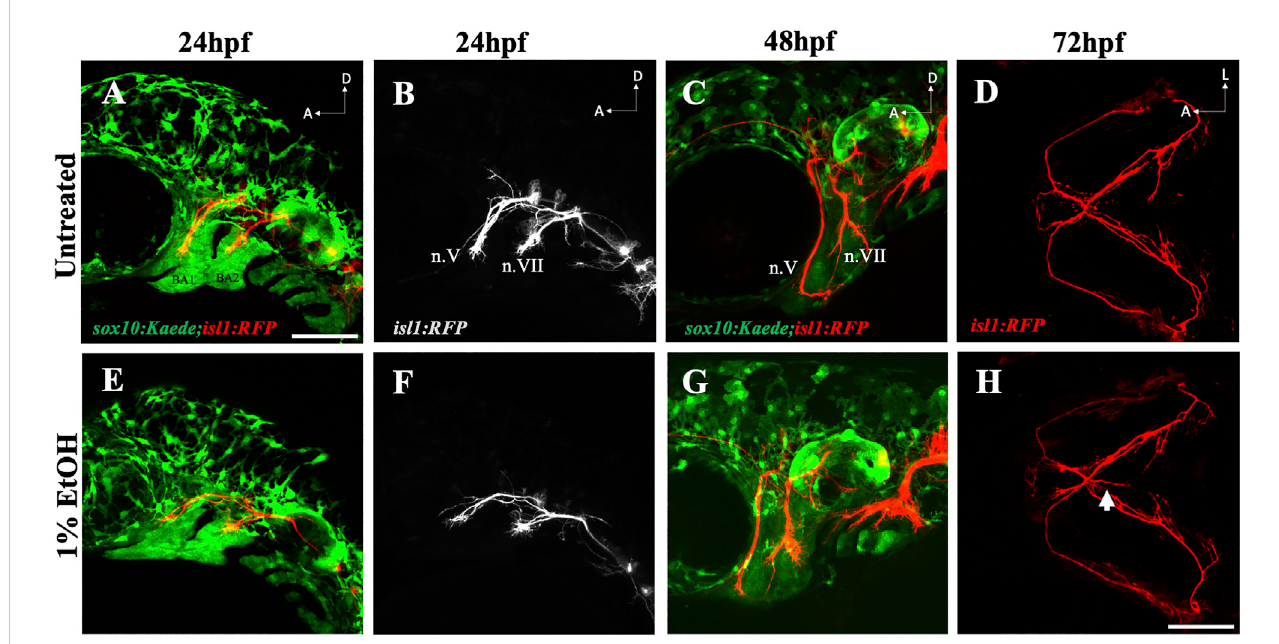
FIGURE 8 Ethanol does not affect early cranial nerve routing and path fi nding (A, B) Trigeminal nerve (n.V) and facial nerve (n.VII) extending towards BA (branchial arch)1andBA2inuntreated sox10:Kaede;isl1:RFP embryoat24hpf. (E,F) Normalextensionofn.Vandn.VIIinethanol-exposed sox10:Kaede;isl1:RFP embryos at 24hpf. (C, G) Untreated and ethanol-exposed sox10:Kaede;isl1:RFP fi sh at 48hpf. (D, H) Untreated and ethanol-exposed isl1:RFP fi sh at 72hpf. Arrow in H shows an extending ectopic nerve along the midline in ethanol-exposed fi sh. Scale bar = 100 um.